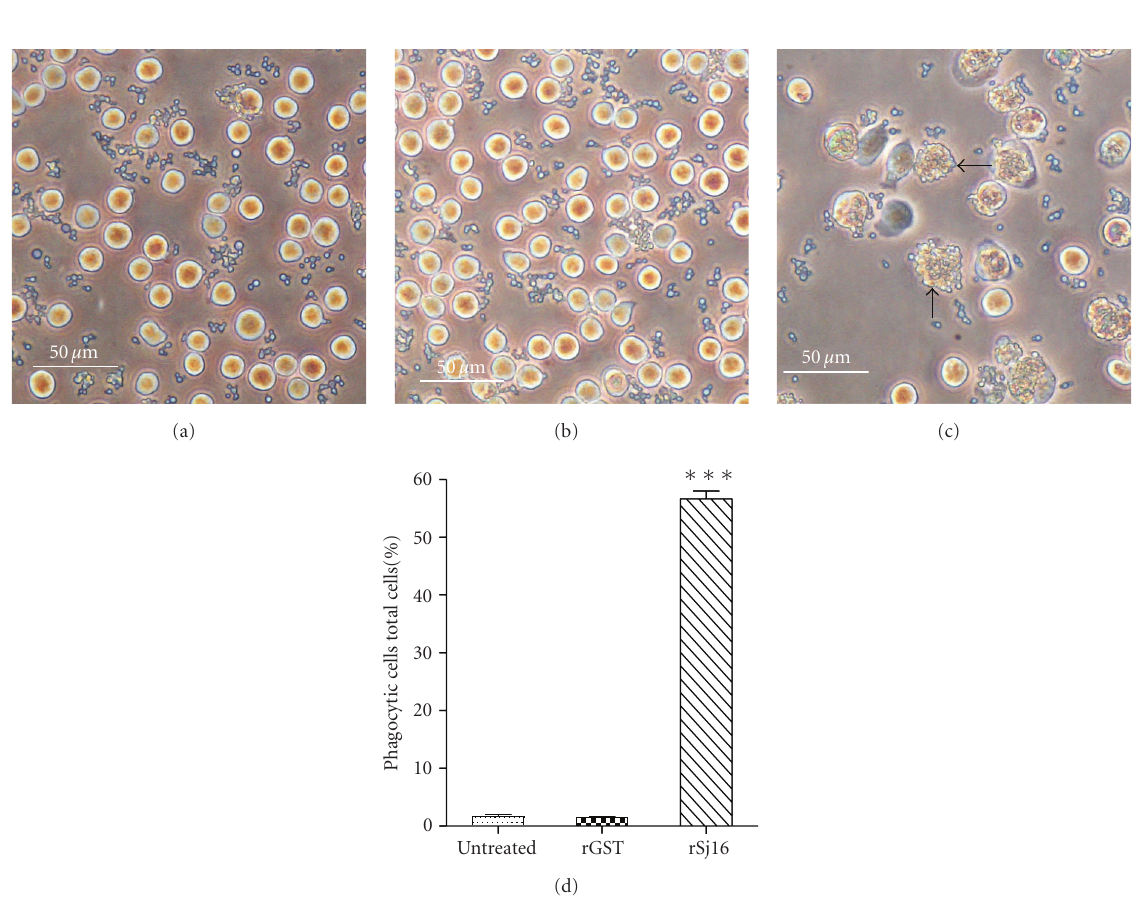
Figure 5: rSj16 induced WEHI-3B JCS cells showed phagocytic activity. WEHI-3B JCS cells were treated for 72 hours with 0.5 μ g/ml rSj16 ( rSj16 , (c)), 0.5 μ g/ml rGST ( rGST , (b)), or medium alone ( untreated , (a)) and then analyzed for the capacity of yeast-ingesting. (a)–(c) Arrows indicate the yeast-ingesting cells. White bars represent 50 μ m (magnification, × 400). (d) Percentage of phagocytic cells after 72hours treatment. The results are the mean ± SEM of three independent experiments. ∗∗∗ P < . 001 as compared with that of untreated